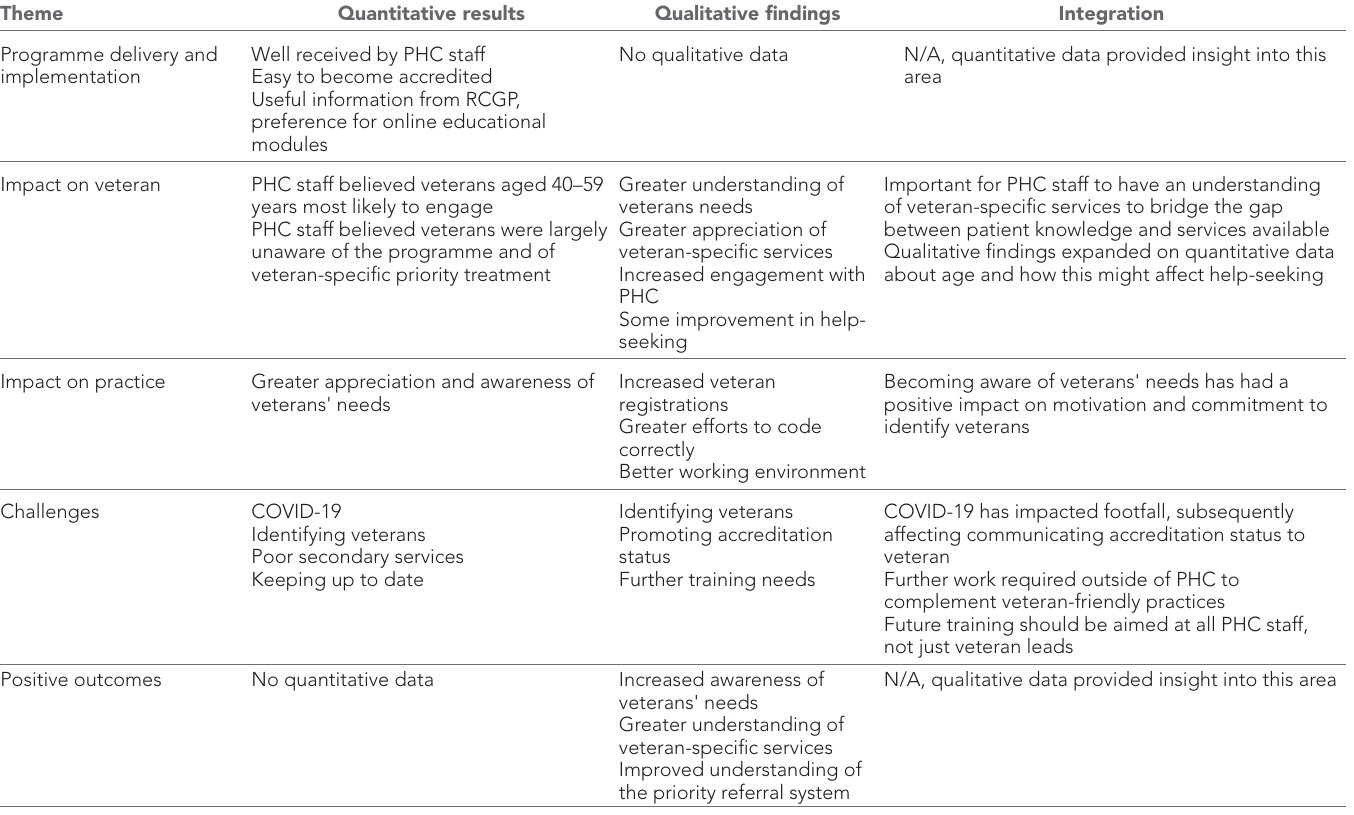
Table 3 Integrated findings from both quantitative and qualitative